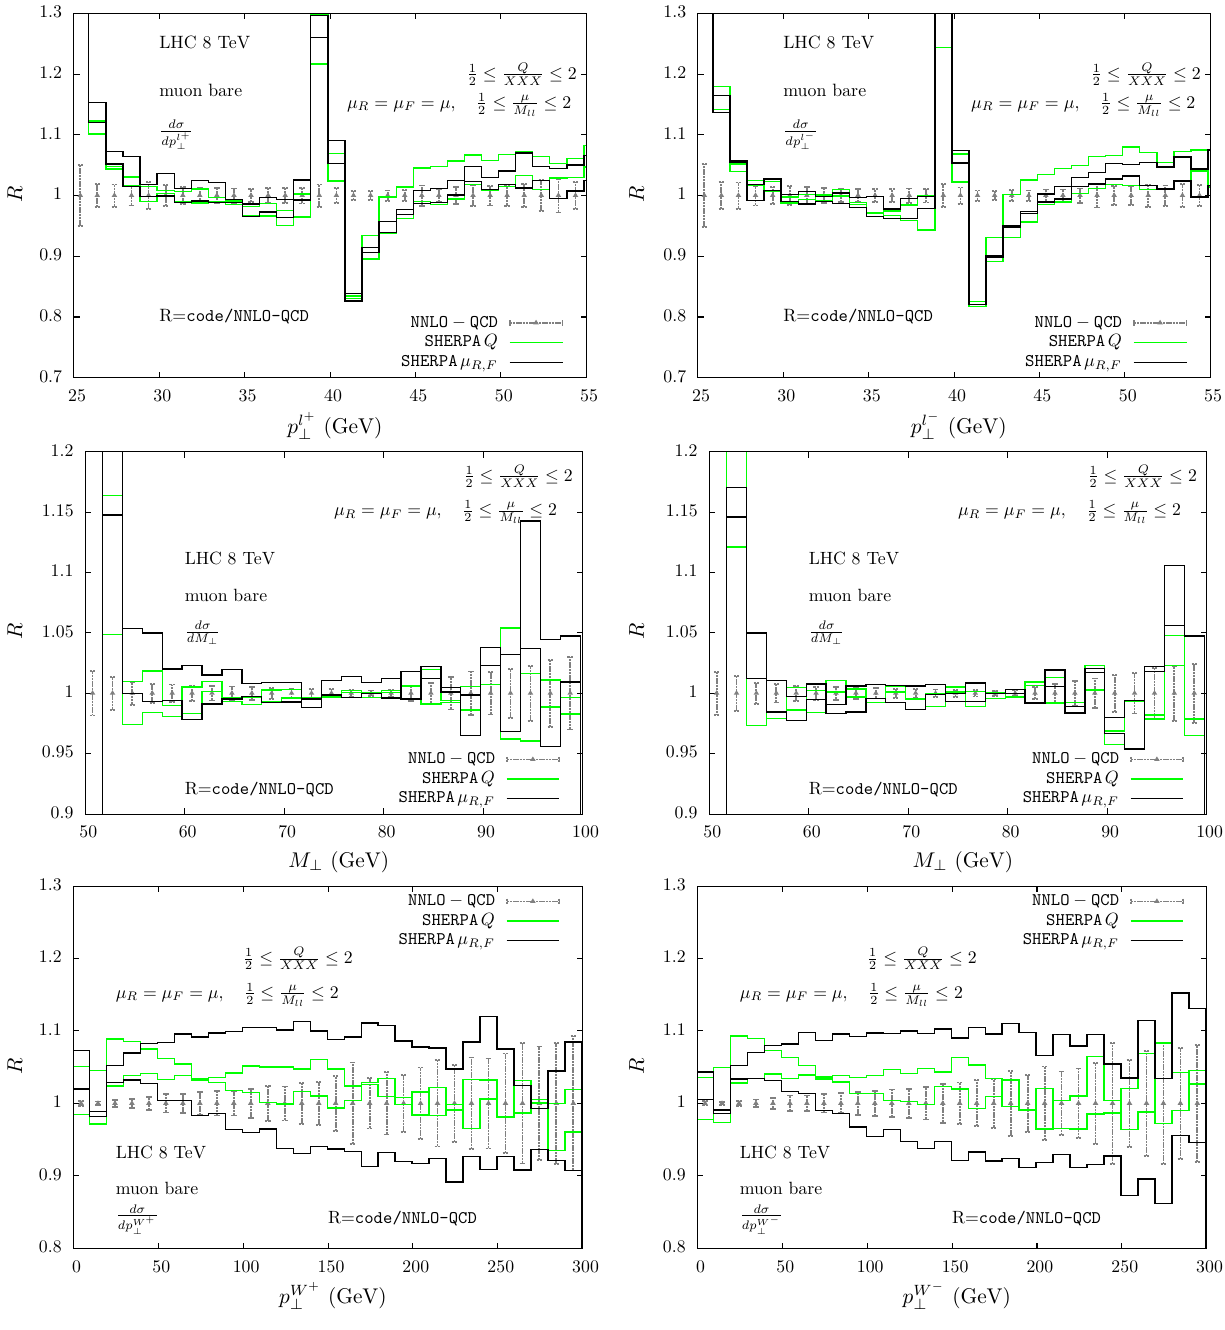
Fig. 22 Higher-order QCD effects, expressed in units of NNLO QCD, due to the matching of resummed and fixed order results, in codes with NNLO accuracy, for the processes pp → μ + ν μ + X ( left plots ) and pp → μ − ¯ ν μ + X ( right plots ), obtained with ATLAS/CMS cuts at the 8 TeV LHC. The SHERPA NNLO+PS uncertainty bands due to renor- back to the zero jet bin to preserve the inclusive cross sec- tion. In order to generate physically meaningful results, the separation cut scale q ⊥ must be smaller than the terminating scale of the parton shower. In contrast to the MiNLO method,